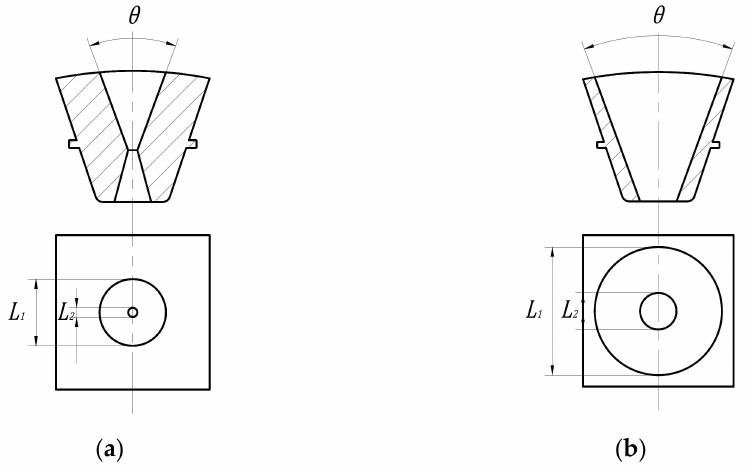
Figure 2. Sketch map of seed filling holes. ( a ) Small seed filling hole; ( b ) Big seed filling